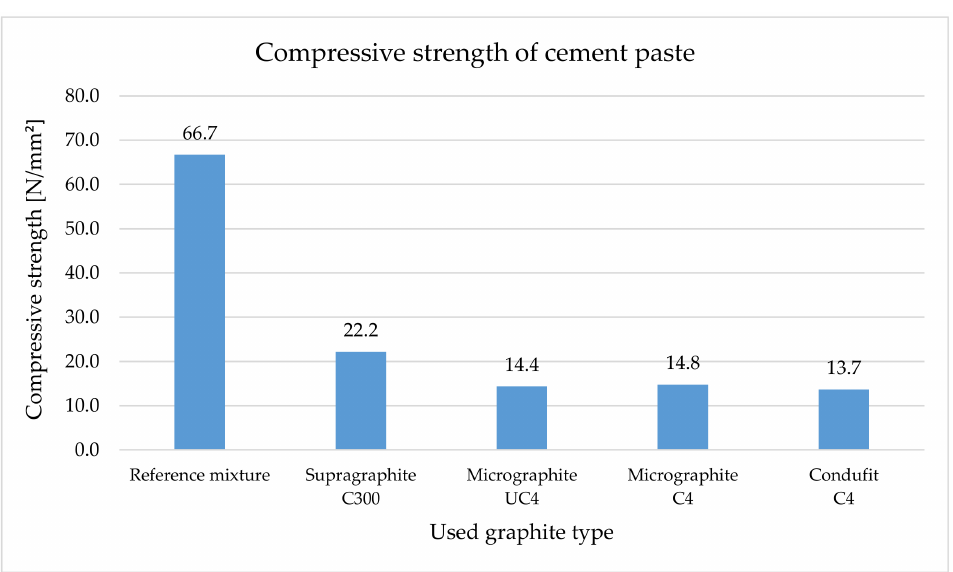
Figure 13. Compressive strength of cement